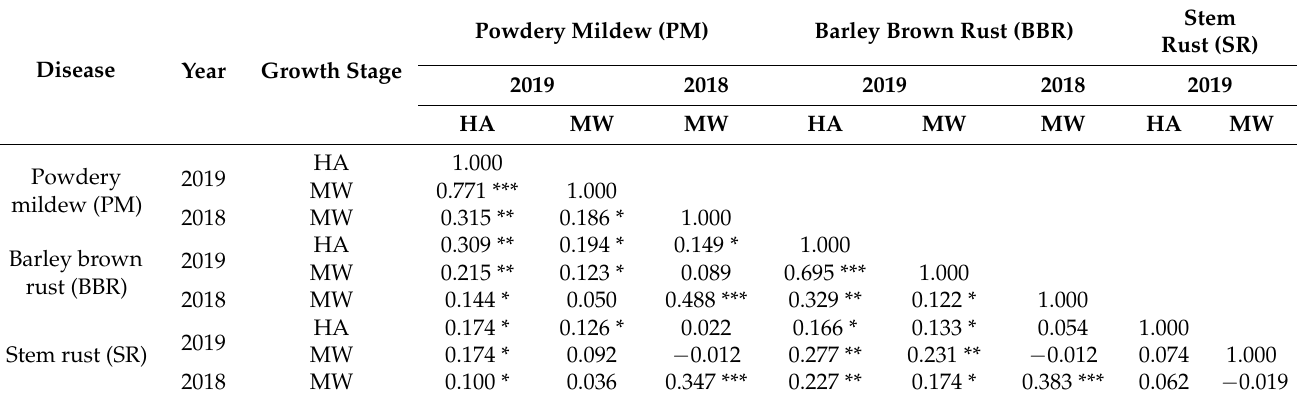
Table 3. Pearson correlation coefficients between resistance to powdery mildew, barley brown rust, and stem rust at heading (HA) and milky-waxy (MW) seed